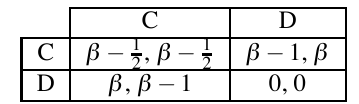
Table 2. Payoff matrix of the Snowdrift game.